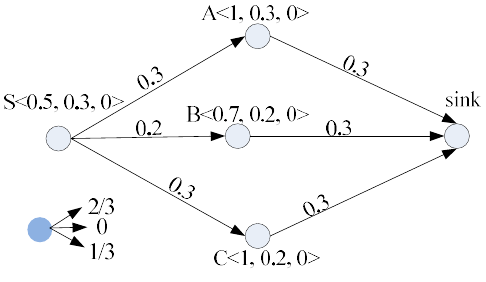
Figure 2. Energy storage overflow (ESO)-reducing routing.